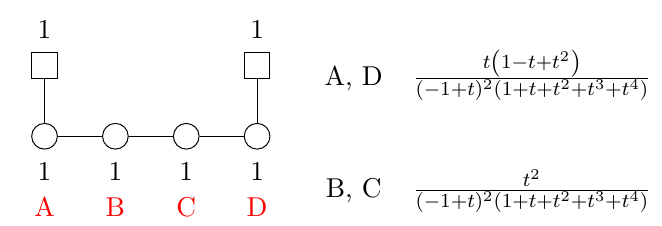
Table 15. E 4 family for k = 1 . B-twisted index with Wilson lines at the labelled position in the quiver.